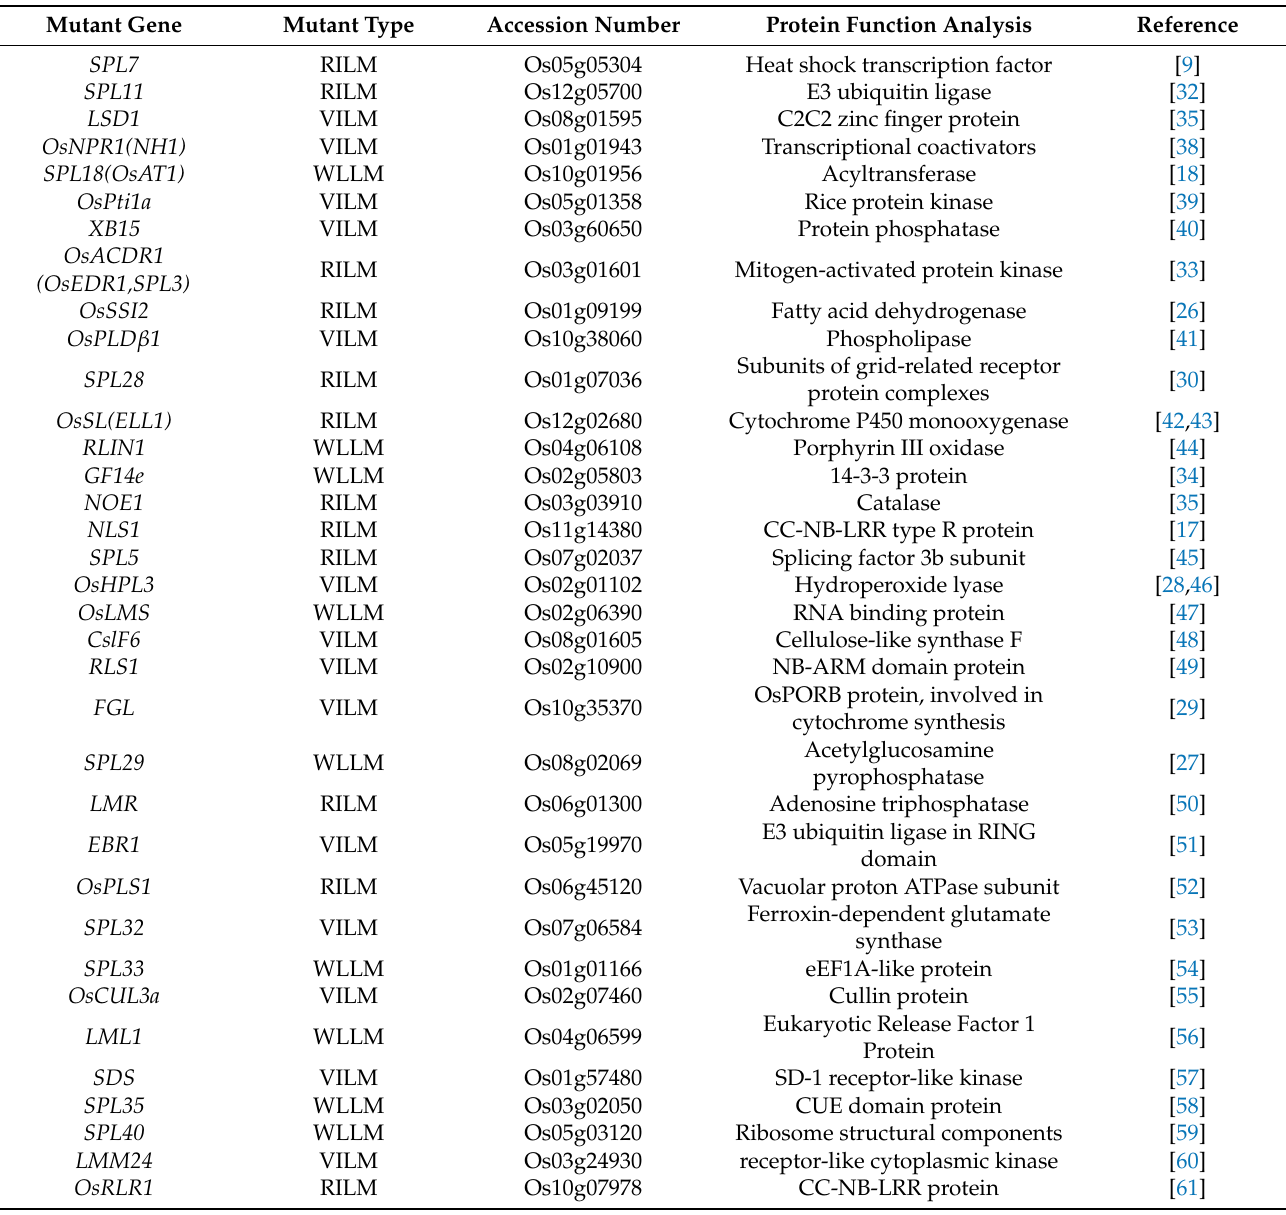
Table 1. Partially cloned 35 rice lesion mimic